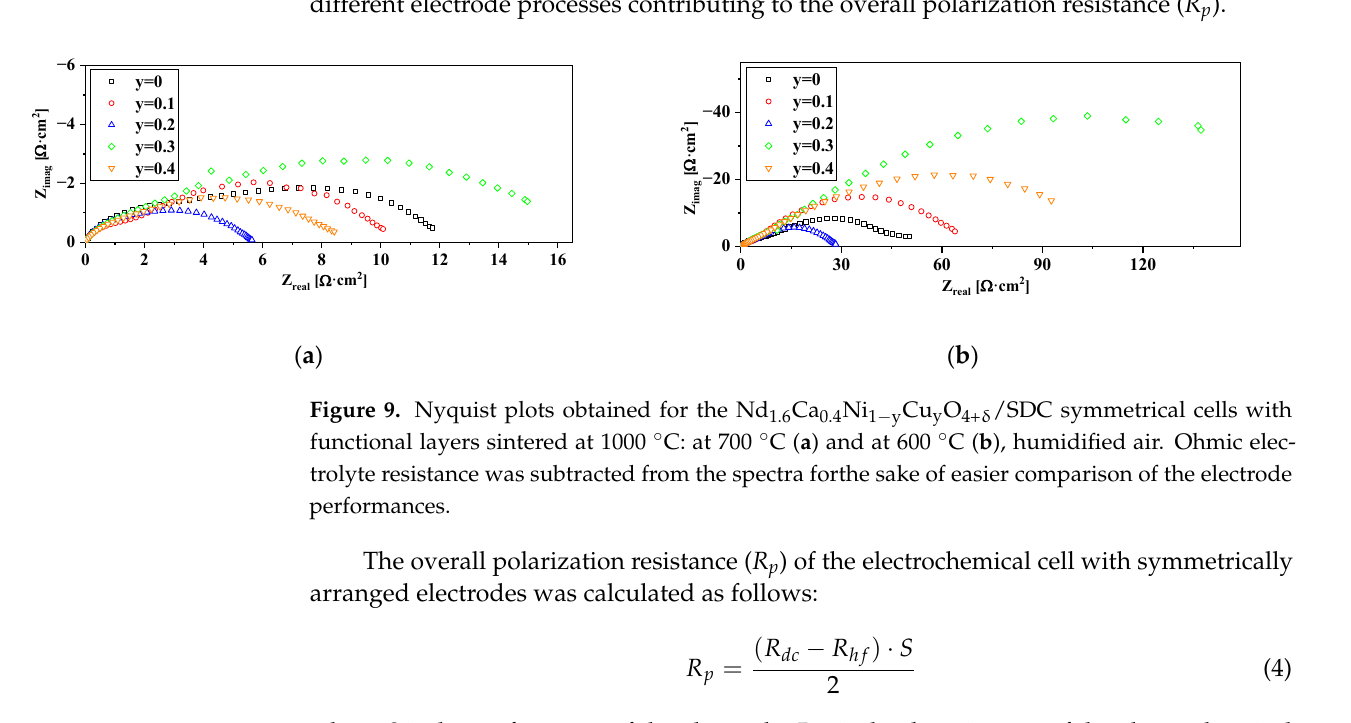
( b ) Figure 8. Arrhenius plots ( a ) and concentration dependencies ( b ) of the oxygen tracer diffusion